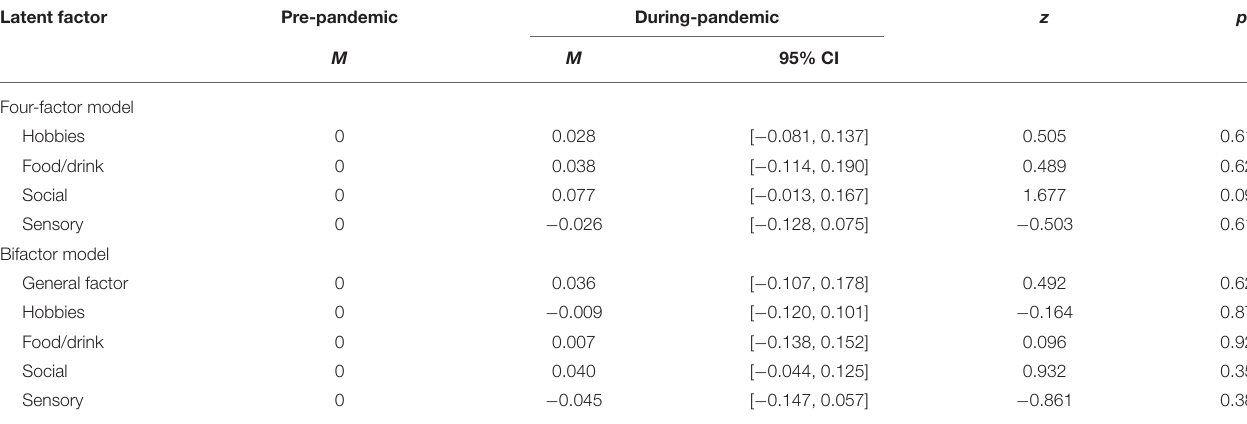
TABLE 7 | DARS latent means group